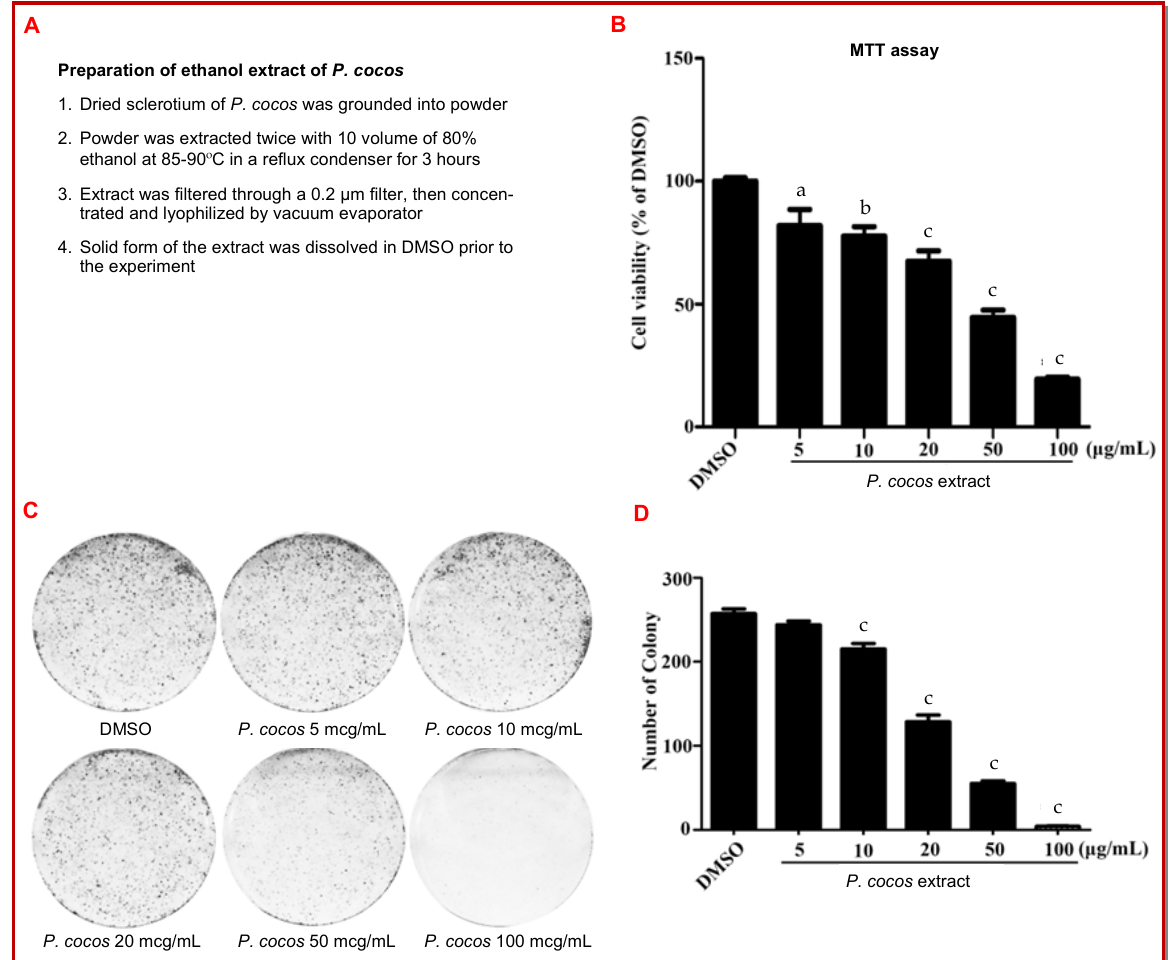
Figure 1: P. cocos inhibits the cell proliferation of Neuro-2a cells. Preparation of P. cocos ethanol extract (A). The percentages of viable cells treated with various concentration of P. cocos (5-100 µg/mL ) for 24 hours, as measured by MTT assay (B). Colony formation of Neuro-2a cells treated with various concentrations of P. cocos (5-100 µg/mL), with staining by crystal violet (C, D). The results represent the mean ± SEM. (n=5). a p<0.05, b p<0.01, c p<0.001, indicated compound vs DMSO, one-way analysis of vari- ance (ANOVA) followed by Dunnett’s